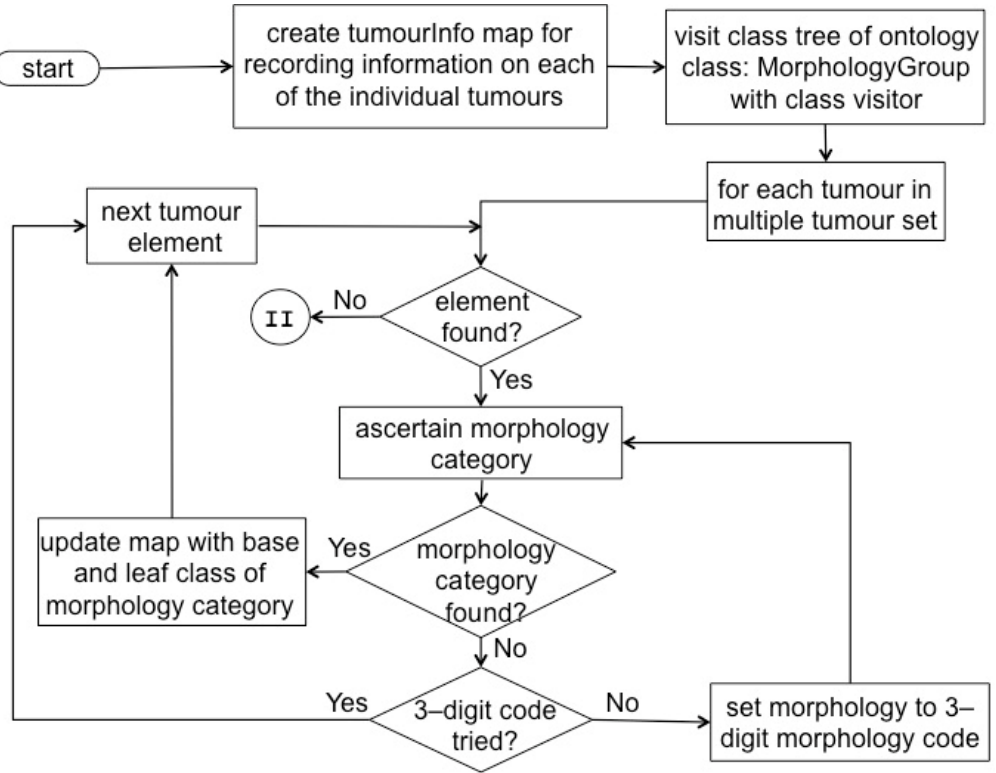
Figure A1. Process for determining the morphology group associated with a morphology code from the ontology axioms.